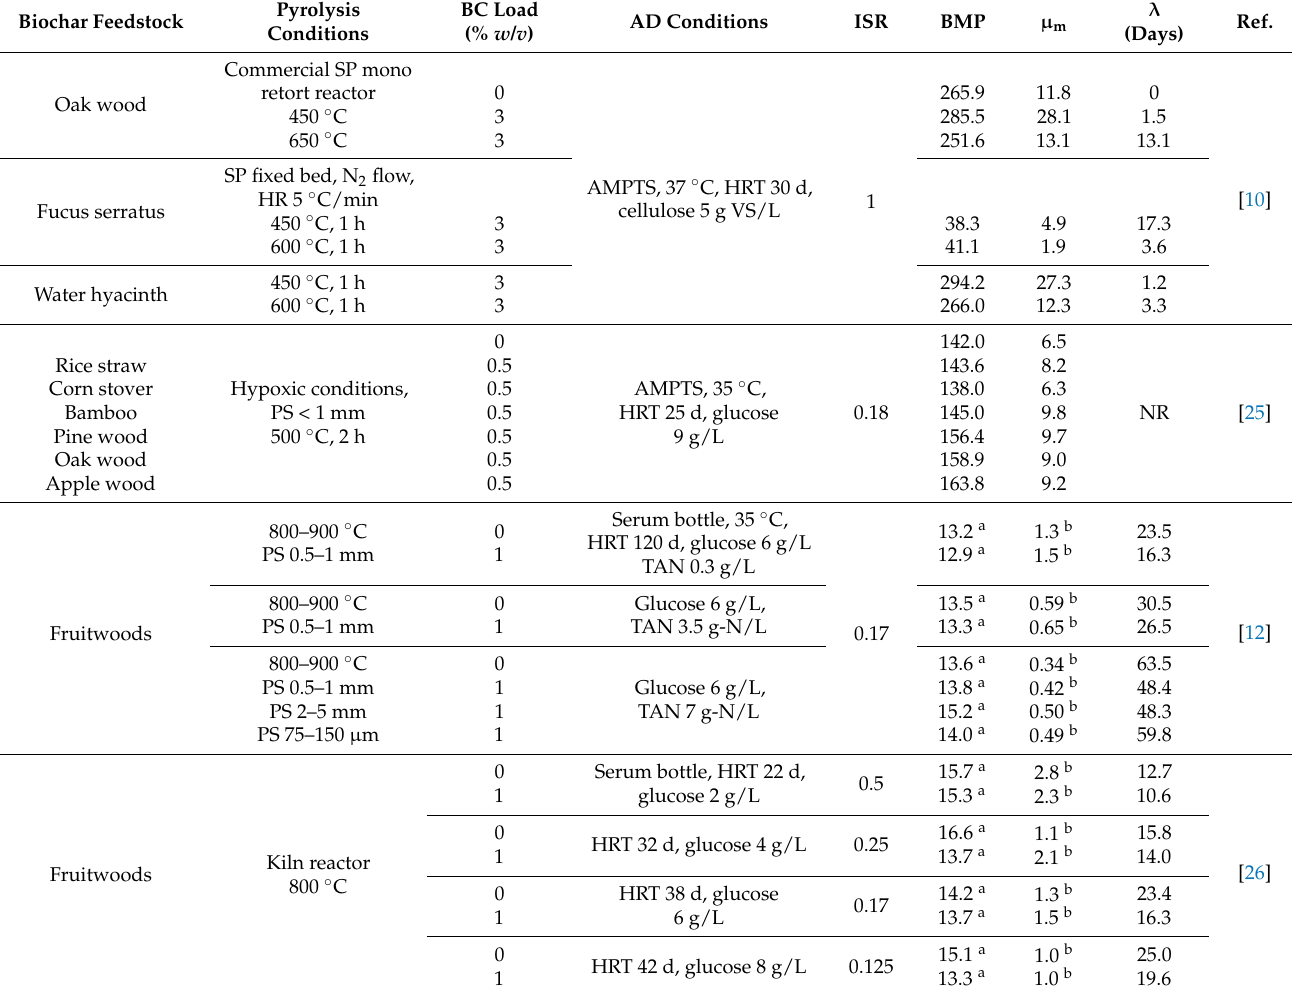
Table 1. Summary of the reports for the biochar addition on anaerobic digestion of model carbohy- drate